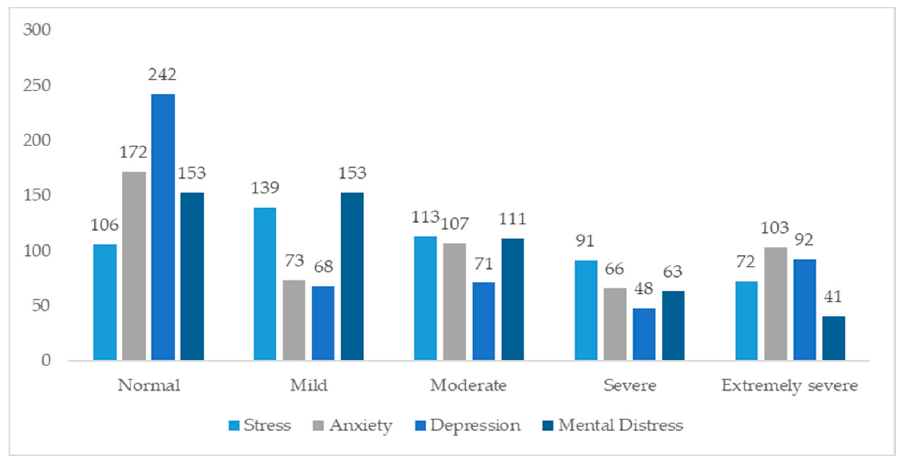
Figure 1. Classification of nursing students (n = 521) according to their levels of Stress, Anxiety, Depression, and Mental Distress.